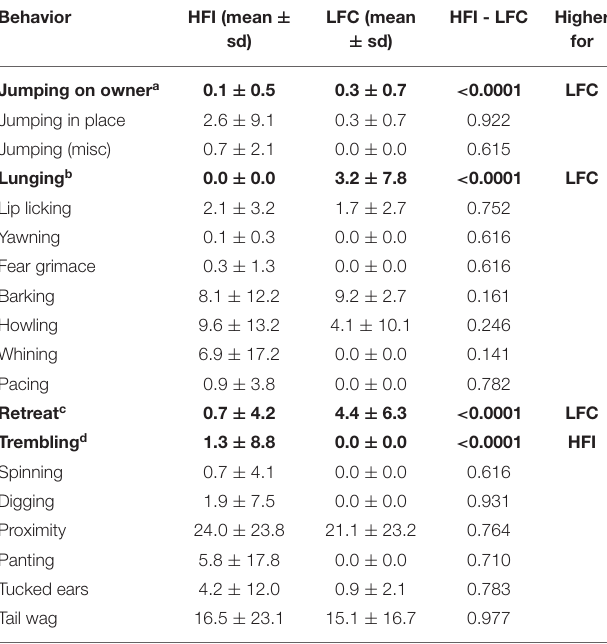
TABLE 7 | Results of the Mann-Whitney U test comparisons between rates of behavior (per minute) by sound source category, HFI (high frequency intermittent) vs. LFC (low frequency continuous); n = 54 n Percentages dev (#videos (%videos behavior behavior seen) seen)